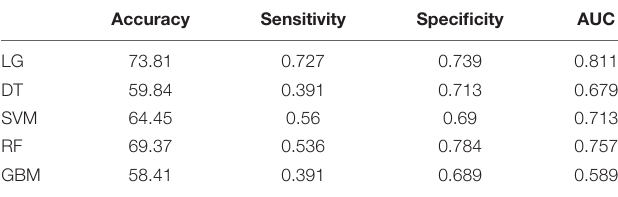
TABLE 4 | Calculation of accuracy, sensitivity, specificity, and AUC after 7-fold cross-validation for different classifiers.